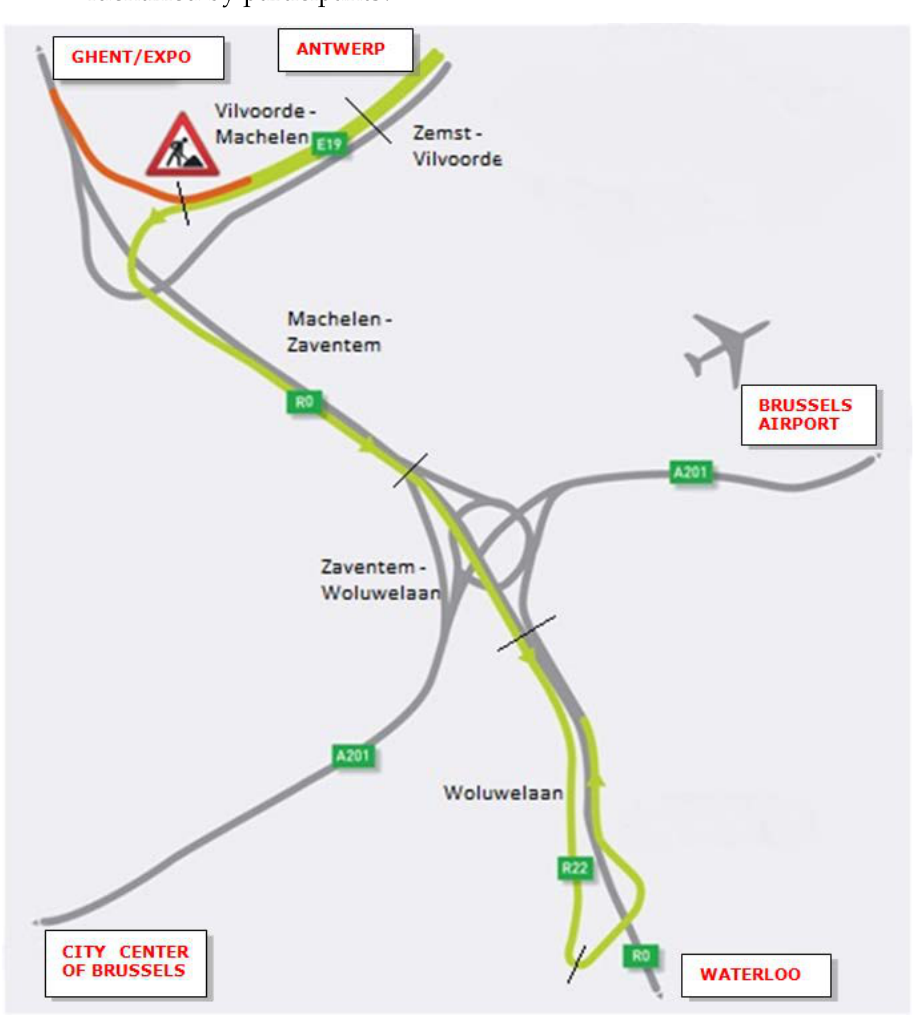
Figure 4. Vilvoorde fly-over